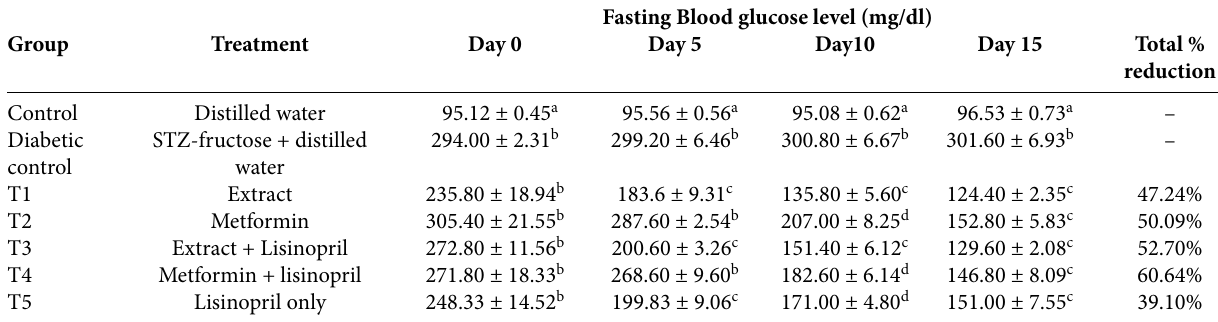
Table 4. Effect of treatments on fasting blood glucose